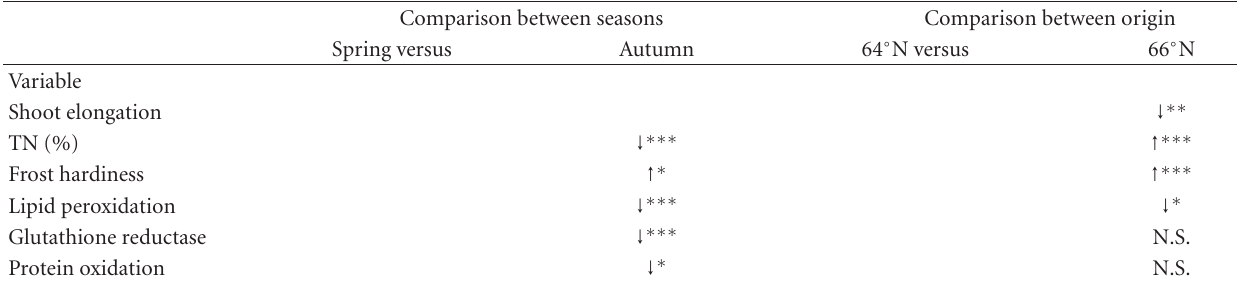
Table 1: Summary of comparisons between origin of the seedlings, and between the seasons of sampling in each analysed biological variable during the studied three-year period (1998–2000). The asterisks denote for statistically significant di ff erence at: ∗ P < . 05, ∗∗ P < . 01, and ∗∗∗ P < . 001. N.S.: nonsignificant.